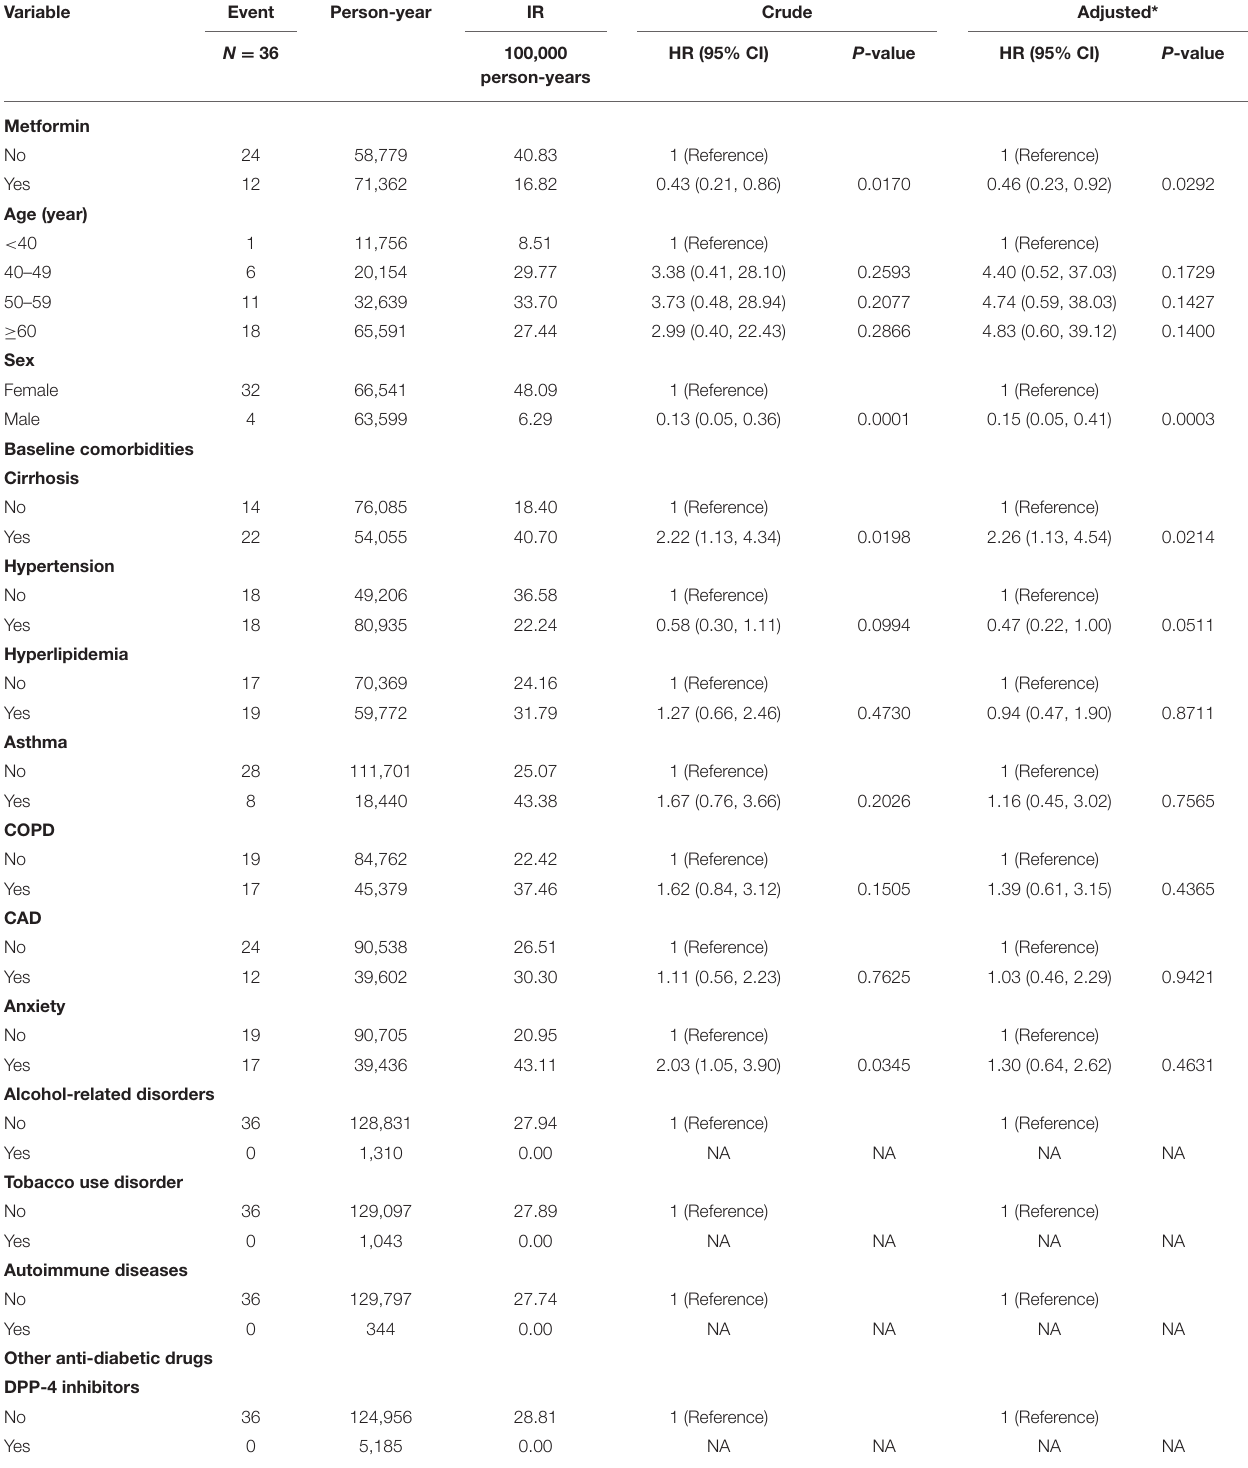
TABLE 2 | Cox regression analyses of Sjögren’s syndrome associated with metformin, demographics, baseline comorbidities, and other anti-diabetic drugs in type 2 diabetic patients.